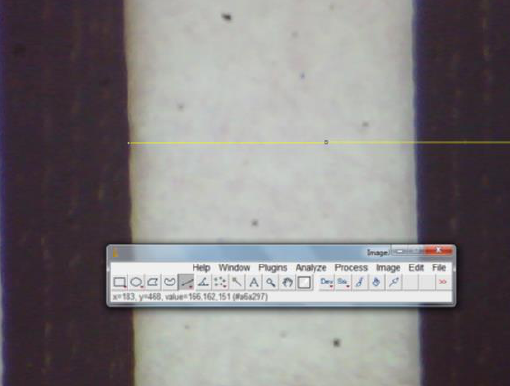
Figure 4: Steps of press crown fabrication. Measurement of the marginal gap